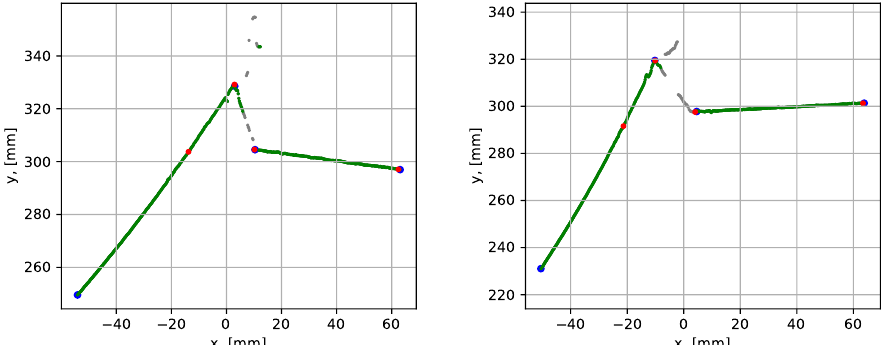
Figure 24. Parametrization results with groove corner points for datasets 10 (to the left) and 11 (to the right). The blue dots show the result before the iterative error elimination procedure and the red dots show after. The grey points have been identified as noise by the noise detection